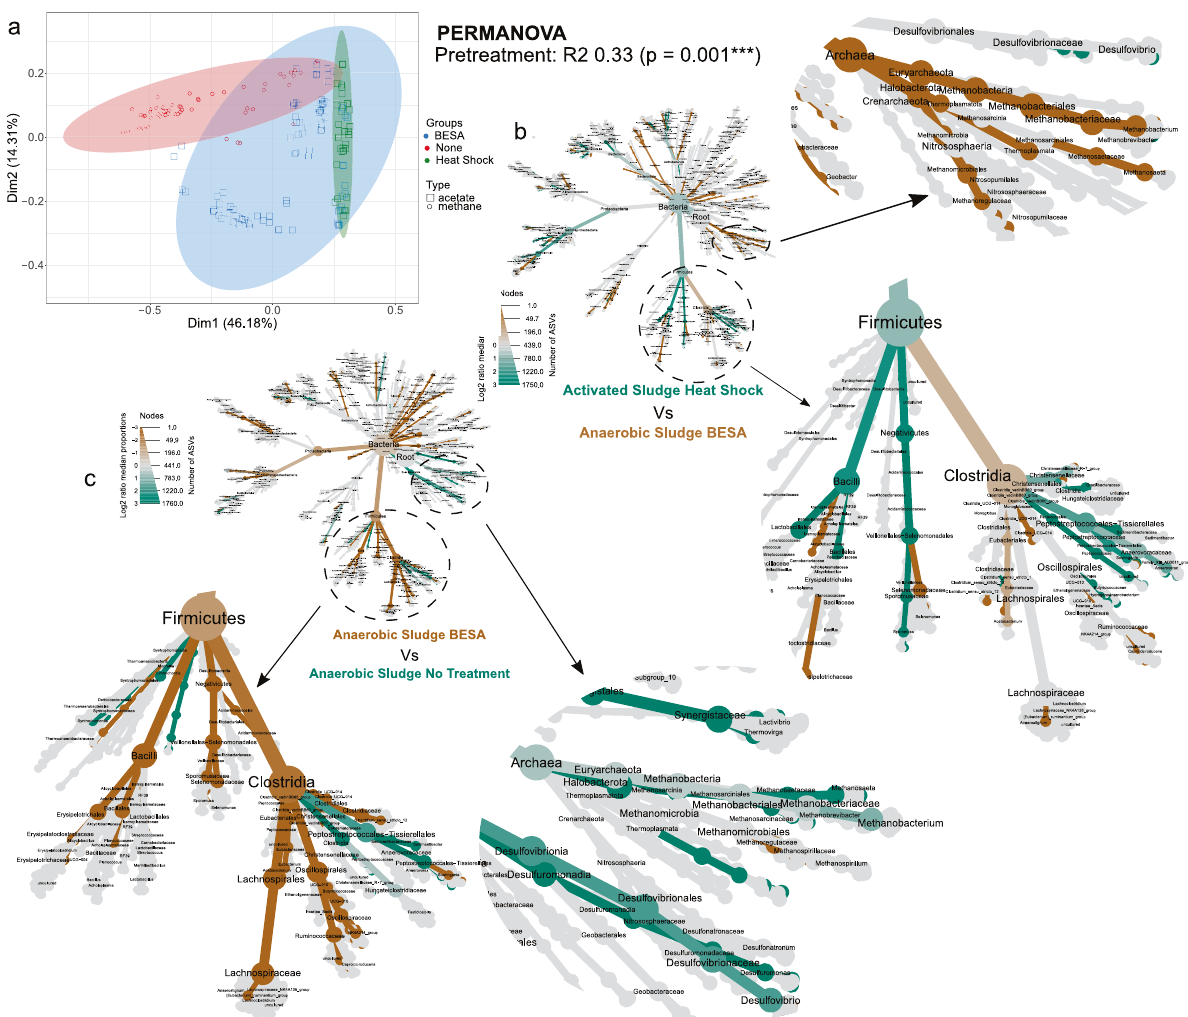
Fig. 3 Effect on inoculum pre-treatment on the microbial communities in MES cells. a Principal Component Analysis (Weighted Unifrac) showing acetogenic and methanogenic samples clustered by pretreatment method where ellipses were drawn using 95% con fi dence intervals based on standard deviation. b Differential heat tree depicting differently abundant taxa between two groups based on seeding strategy (heat shocked activated sludge Vs BESA treated anaerobic sludge). The circle size and the colour intensity re fl ect the species abundance and the log2 median proportion between the two groups respectively. c Differential heat tree depicting differently abundant taxa between two groups based on seeding strategy (untreated anaerobic sludge Vs BESA treated anaerobic sludge). The circle size and the colour intensity re fl ect the species abundance and the log2 median proportion between the two groups respectively. Full size, high-resolution heat trees are provided in the Supplementary Information (Supplementary Figs. 6,